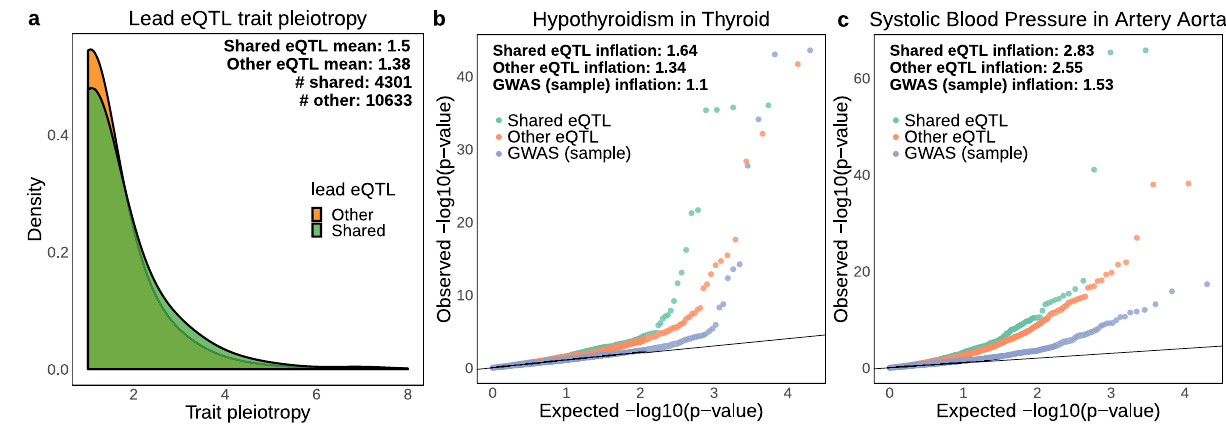
Fig. 5 Comparison of trait pleiotropy and association p -values between shared and other lead eQTLs. a Distribution of trait pleiotropy (association p - value < 5e − 8 ) across 35 UKBB GWAS traits. If a lead eQTL is shared in at least one tissue (even if not in other tissues) it is considered as “ shared ” . The remaining lead eQTLs compose the “ other ” category. Only lead eQTLs associated with at least one trait were considered; b, c Q – Q plots of association p - values ( − log10 scale) for known tissue-trait matched pairs (hypothyroidism in thyroid tissue and systolic blood pressure in artery aorta), comparing shared (green) and other (orange) lead eQTLs. GWAS (blue) is a sample of 10,000 variants (randomly and independently picked for each trait) shown only for comparison